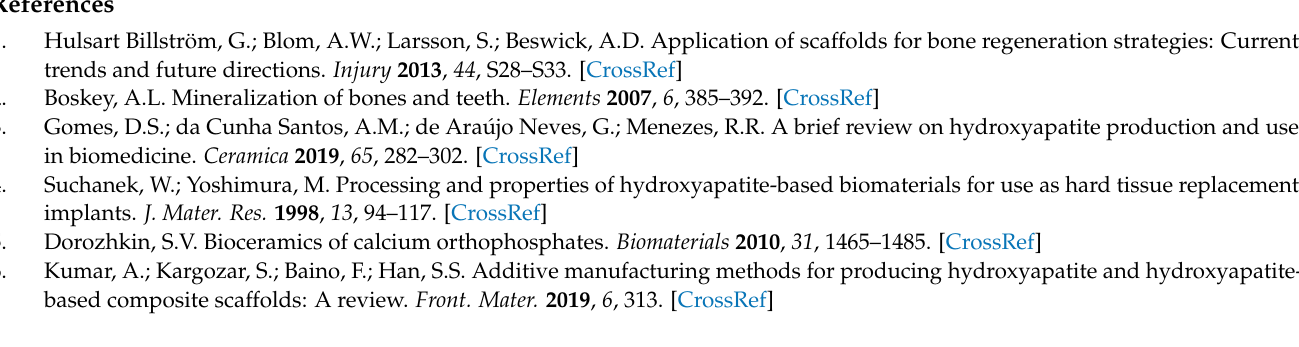
Figure 4. Elastic modulus: comparison between the results from the models listed in Table 1 and experimental data ( n = 20, * p < 0.05).